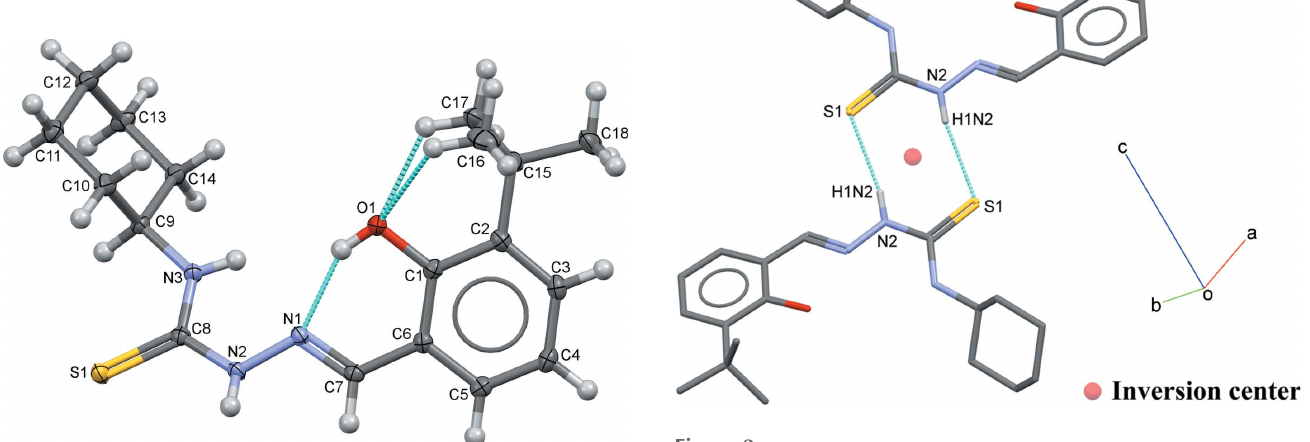
Figure 2 Aview of a centrosymmetric dimer of C 18 H 27 N 3 OS with N2—-H1 N 2 (cid:3)(cid:3)(cid:3) S1 hydrogen bonds shown as cyan dotted lines. Hydrogen atoms not involved in with these interactions are omitted for clarity.